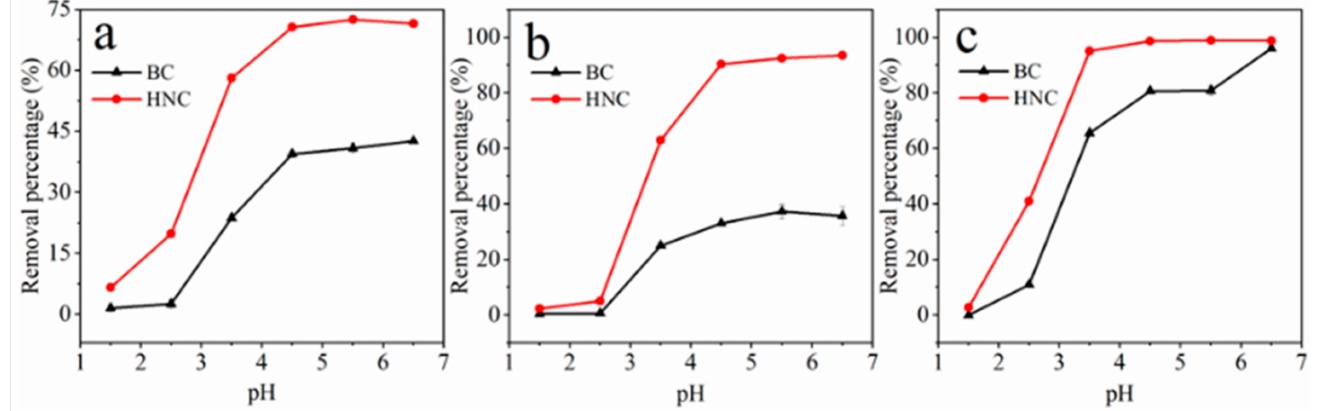
Figure 3. Effect of initial pH on adsorption of Cu 2+ ( a ), Cd 2+ ( b ) and Pb 2+ ( c ) by BC and HNC; dosage of 2 g/L for Cu 2+ and Cd 2+ and 1 g/L for Pb 2+ , time of 240 min, initial concentration of Cu 2+ , Cd 2+ and Pb 2+ of 50 mg/L, temperature 298.15